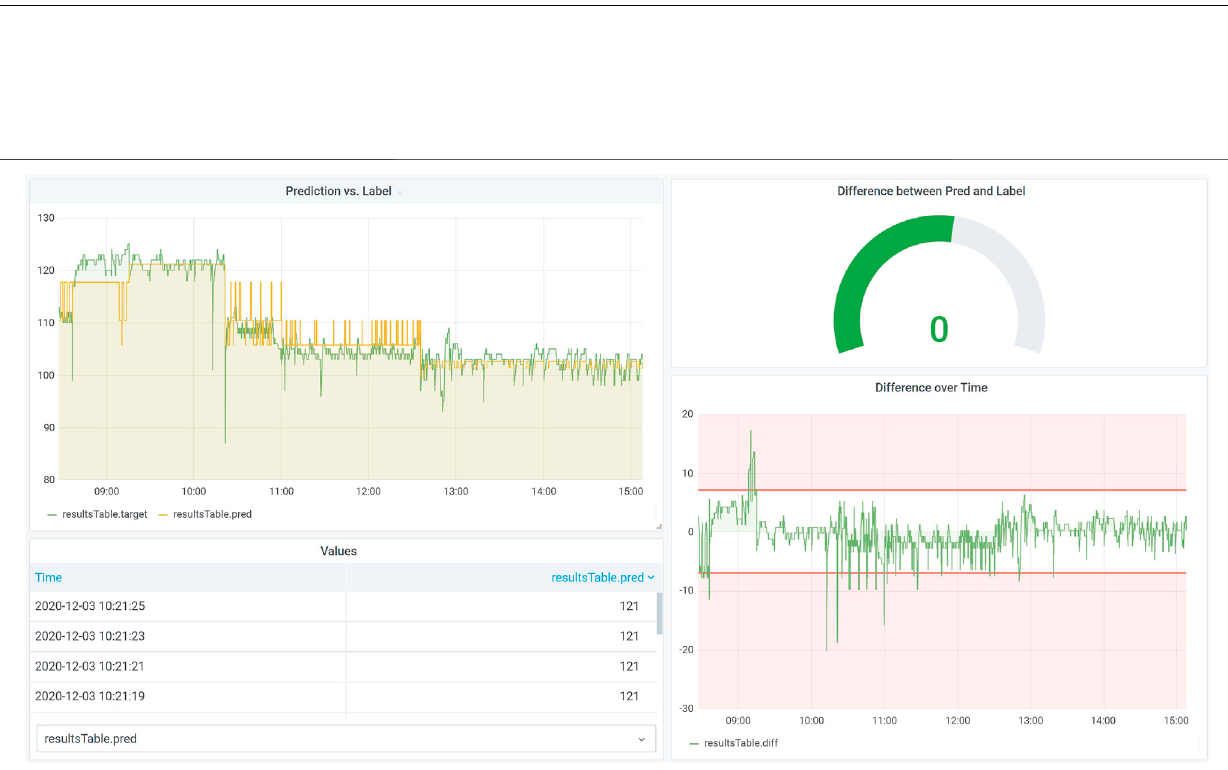
FIGURE 6 | Model performance visualization in Grafana. This mock-up scenario covers the visualization of predicted and real values when estimating the performanceofapredictionmodel.Theperformancesurveillanceisnecessarytoinitiatechangespriortoarisingproblemsandindicateswhetheramodelstill fi tsorithas to be